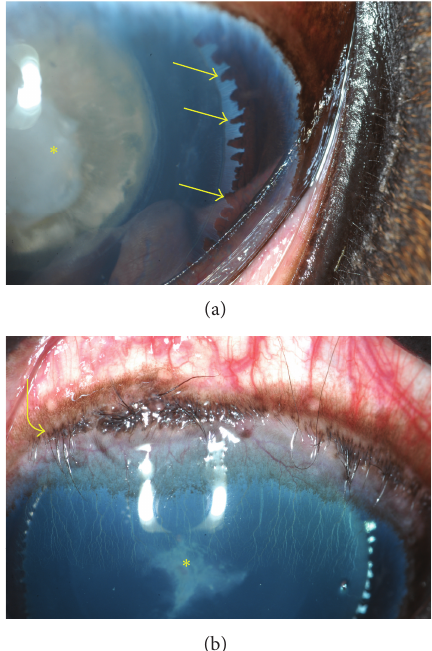
Figure 1: Horse B. (a) Left eye. Due to the absence of any grossly vis- ible iris, the ciliary processes are easily seen (arrows). An immature nuclear cataract is also present (asterisk). (b) Right eye. Short hairs emanating from the corneoscleral limbus are considered variants of limbaldermoids(curvedarrow).Anincipientcataractisalsopresent (asterisk).